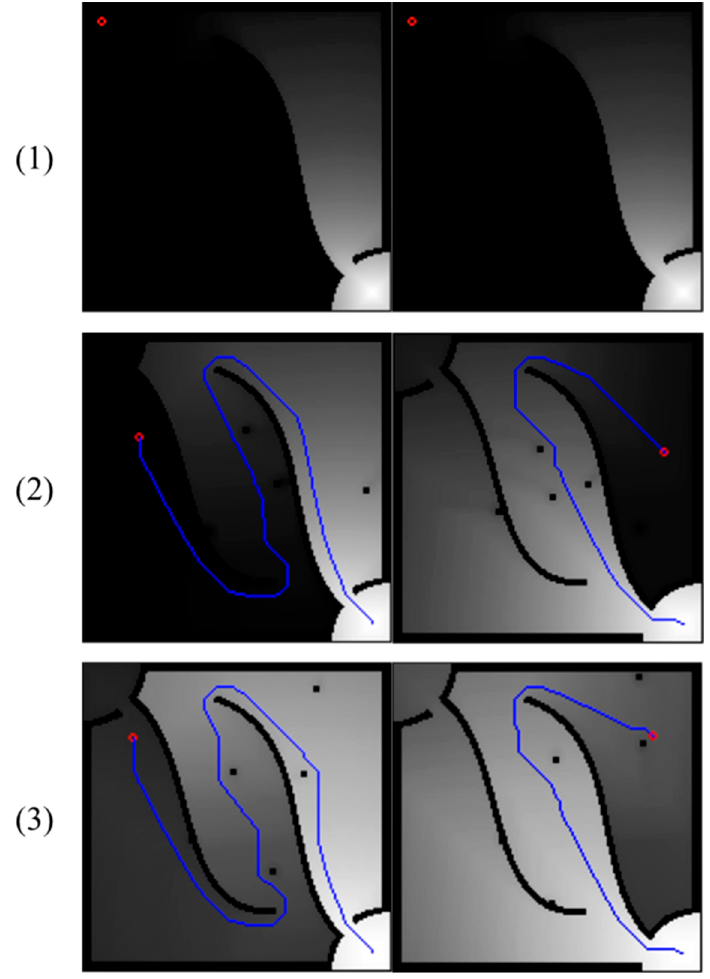
Figure 9. Comparison of different γ values. (1) γ = 0.98 (2) γ = 0.99 (3) γ = 0.995.